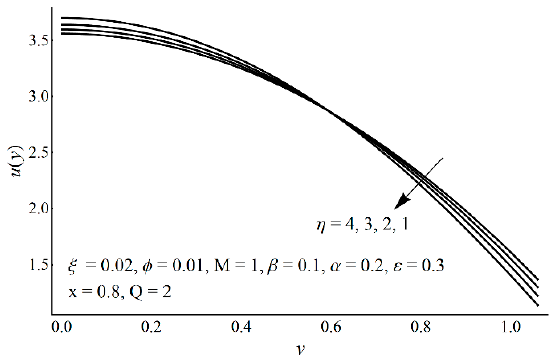
Figure 5. Axial velocity for different values of time relaxation parameter ϕ .